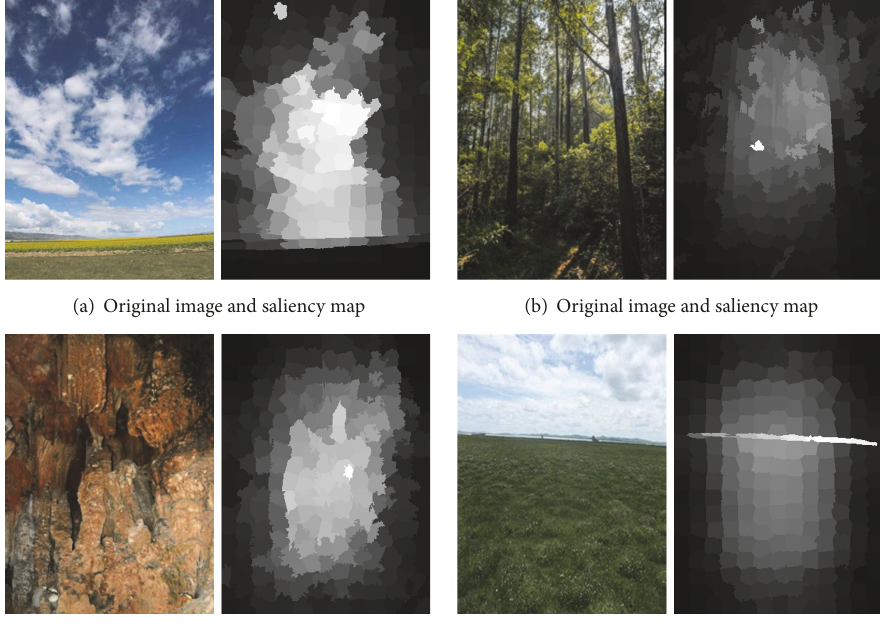
Figure 6: Original image and saliency map